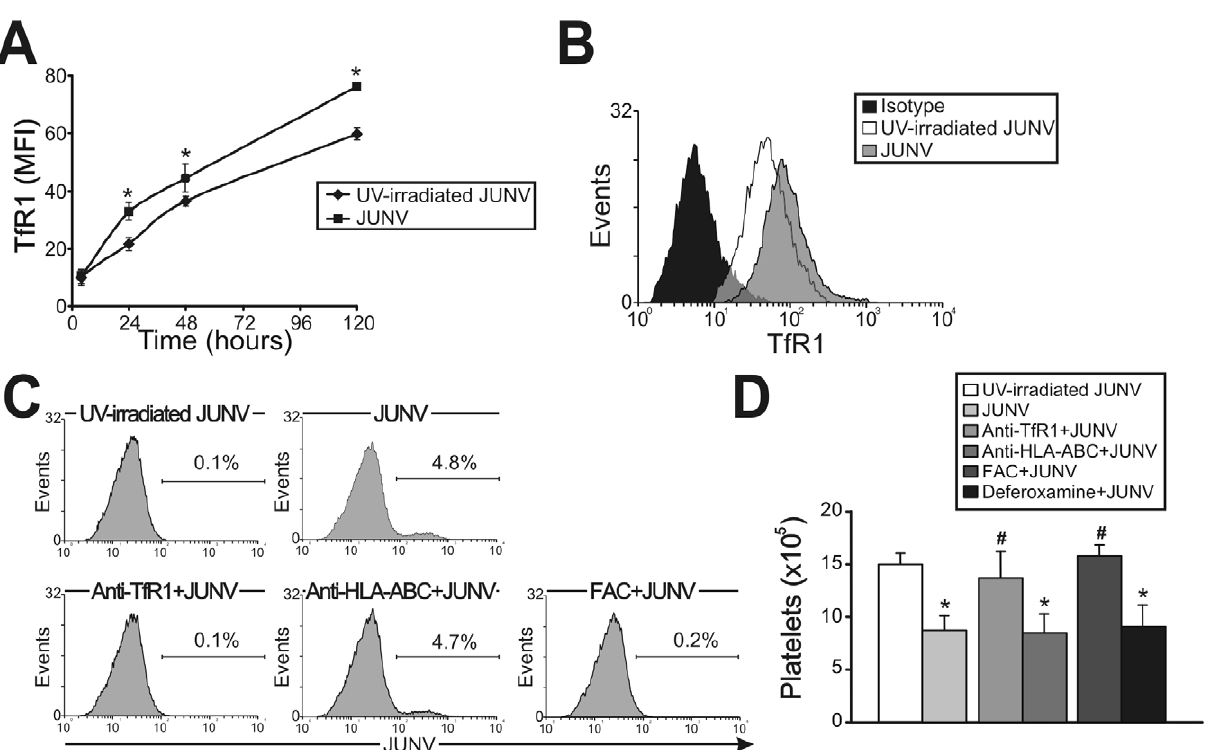
Figure 5. Role of TfR1 in JUNV infection and impaired platelet production. (A) The kinetics of TfR1 expression after JUNV infection in CD34 + cells stimulated with TPO were determined by flow cytometry. (B) Receptor expression was detected in UV-irradiated JUNV- and JUNV-infected cells incubated with FITC-anti-CD71 (anti-TfR1) mAb or with a matched isotype control. The histogram depicts a representative flow cytometric analysis of TfR1 staining after 120 hr of infection. (C) CD34 + cells were pre-incubated with an anti-CD71, anti-HLA-ABC mAb or ferric ammonium citrate (FAC, 10 m g/ml) for 1 hr (to down-regulate TfR1). Cells were then infected with JUNV and stimulated with TPO and viral antigens were detected by flow cytometry. The figure shows a representative experiment of three similar replicates. (D) CD34 + cells were treated as mentioned in C, and also with deferoxamine (1 m M) for 24 hr (to up-regulate TfR1). Platelets produced in culture were counted at day 15. The values represent the mean 6 SEM of three independent experiments,* indicates p , 0.05 vs. UV-irradiated JUNV, # indicates p , 0.05 vs.